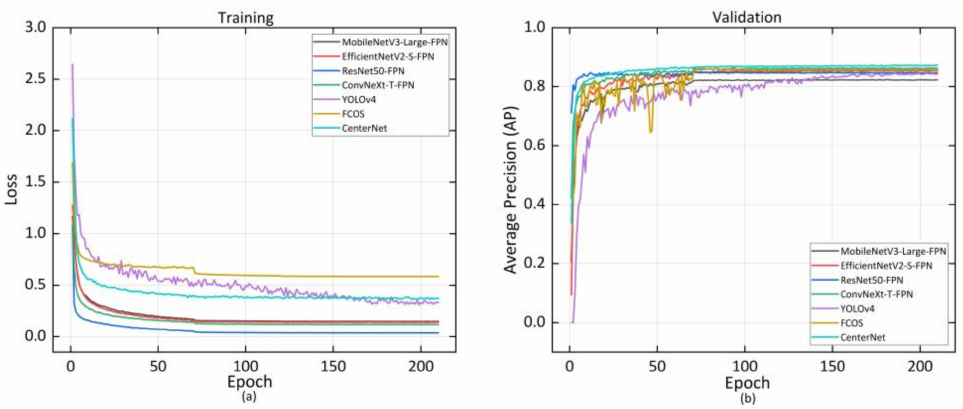
Figure 4. The training loss curve ( a ) and AP curve ( b ) of the posture detection